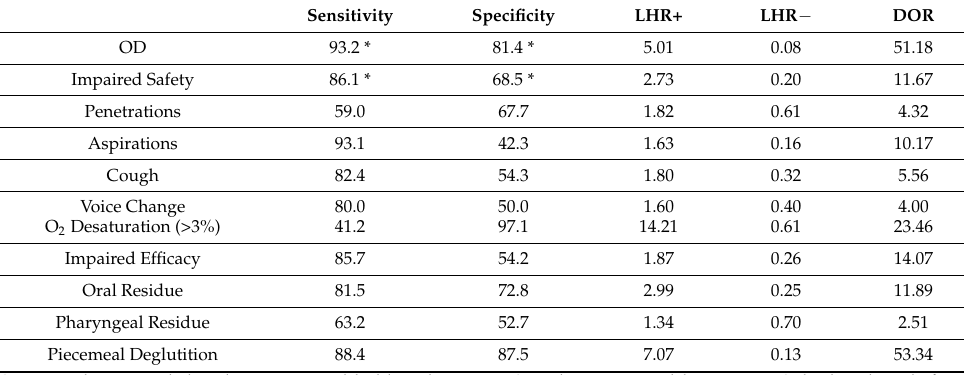
Table 3. Summary of the main psychometric properties of the volume-viscosity swallow test (V-VST) for oropharyngeal dysphagia (OD) and all the clinical signs of impaired safety and efficacy of swallow evaluated with the